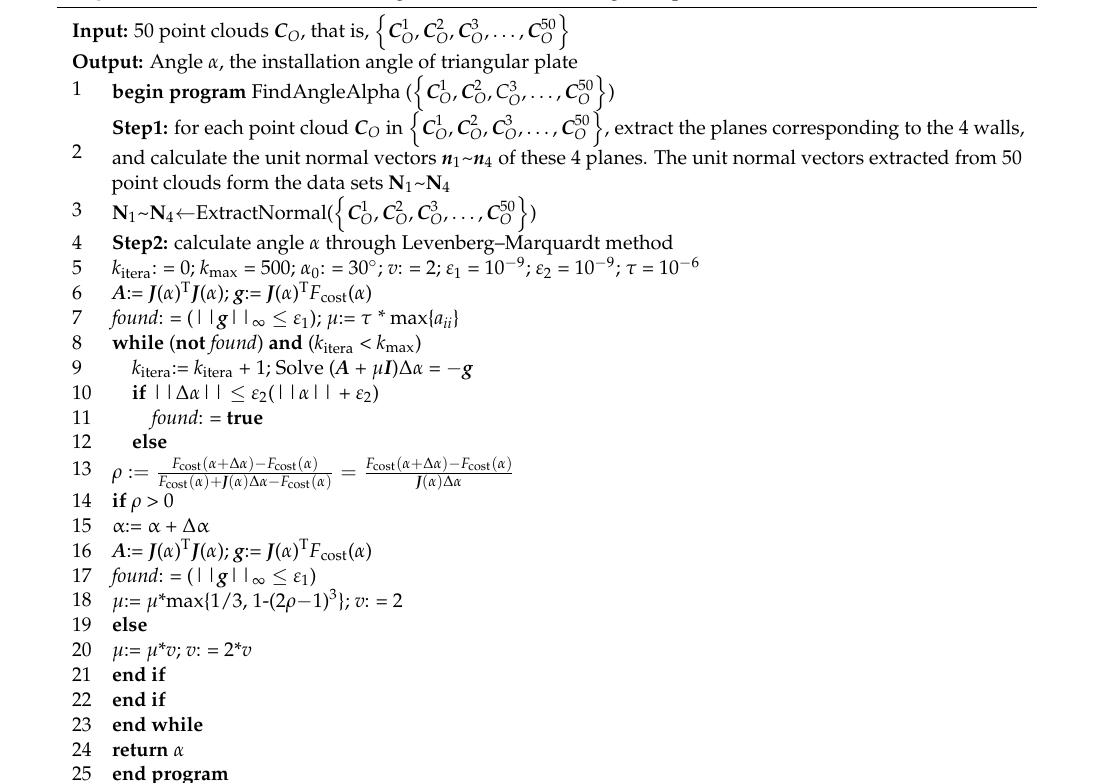
Algorithm A1 The Calibration of Angle α Based on Levenberg–Marquardt